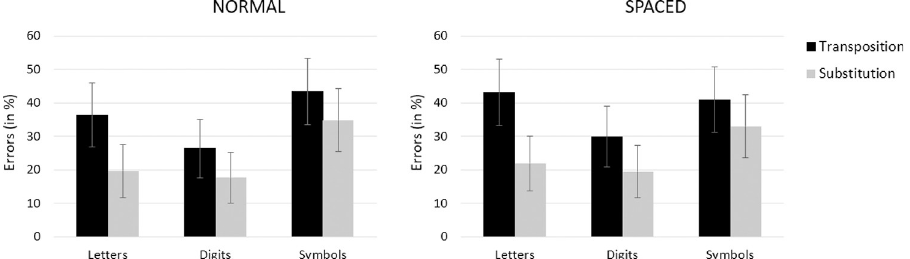
Fig 5. Error rates for each type of stimulus in the transposition and in the substitution conditions when the target string was presented with normal spacing (left panel) and when it was presented with an extra space between characters in target stimuli (right panel) in Experiment 2. Error bars represent within-participant 95% CIs [44].